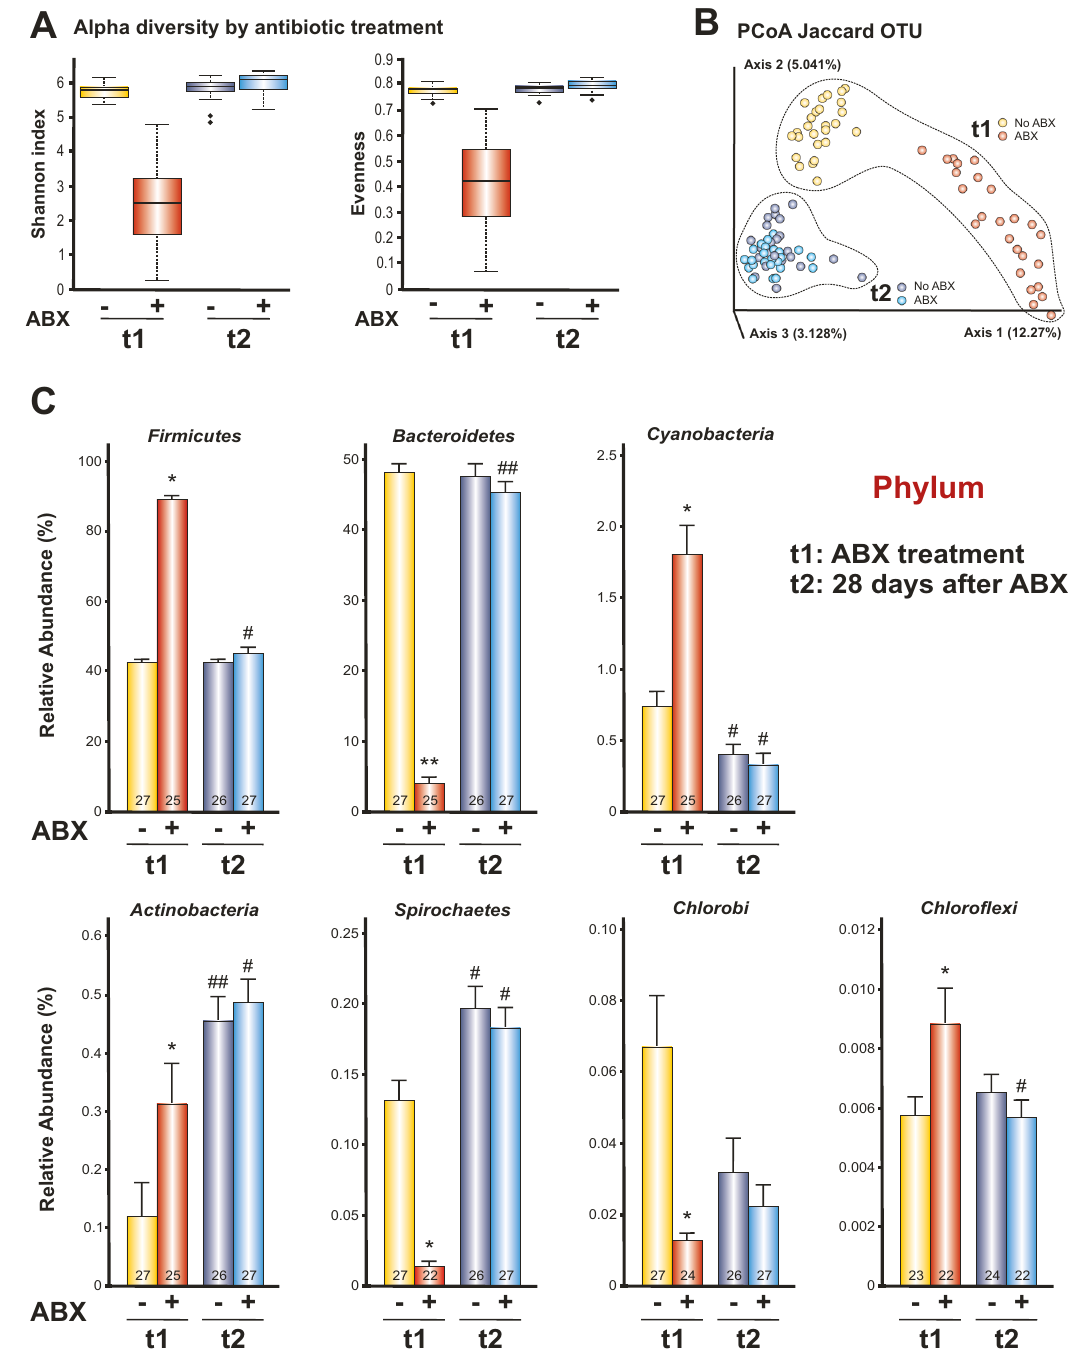
Fig. 3 Effect of antibiotics and alcohol on IMB in rats. Antibiotics cause signi fi cant differences in Alpha diversity ( p < 0.0001) ( A ) and Beta diversity (Jaccard distance index, p < 0.001) ( B ). This effect disappeared after four weeks. C Effects of the antibiotic treatment and alcohol consumption in relative abundance at phylum level. Signi fi cant differences between groups treated with antibiotic and non-antibiotic in t1: * p < 0.05; ** p < 0.01. Signi fi cant differences within the same group between t1 and t2: # p < 0.05; ## p < 0.01. C graph represents mean ± s.e.m. Source data are provided as a Source Data fi alcohol consumption is usually associated with diarrhea [31]. The motivation for alcohol consumption partially depends on the results obtained suggest that alcohol would lead to a reduction in content of the IMB. In the fi rst part of the study, we examined the bowel motility, causing a longer stay of food in the intestine and phenotype of human feces through the Bristol Stool Scale, absorbing virtually all the water contained in those foods, leading showing that heavy episodic drinking was associated with a to changes in stool consistency. This would be in accordance with speci fi c type of stool. Those who consumed more alcohol had the data obtained by Wegener et al., who showed an abnormally more prevalently stool type I, described as separate hard lumps, delayed gastric emptying in chronic alcoholics [32]. As long as like nuts-hard to pass. This is an unexpected result since excessive